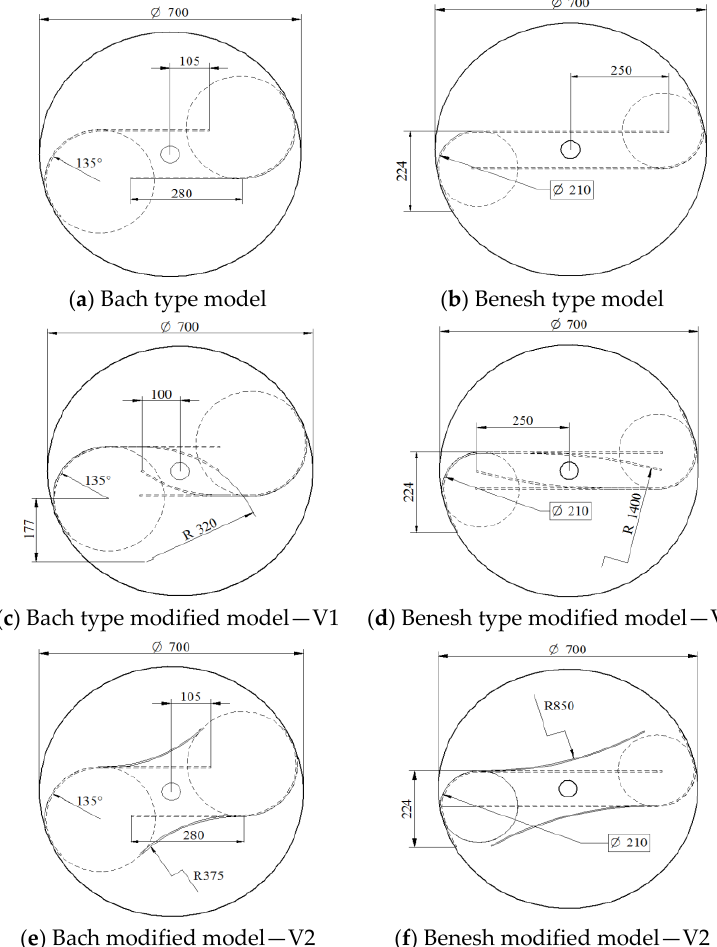
Figure 5. Main rotor model types considered for numerical analysis (dimensions in mm).